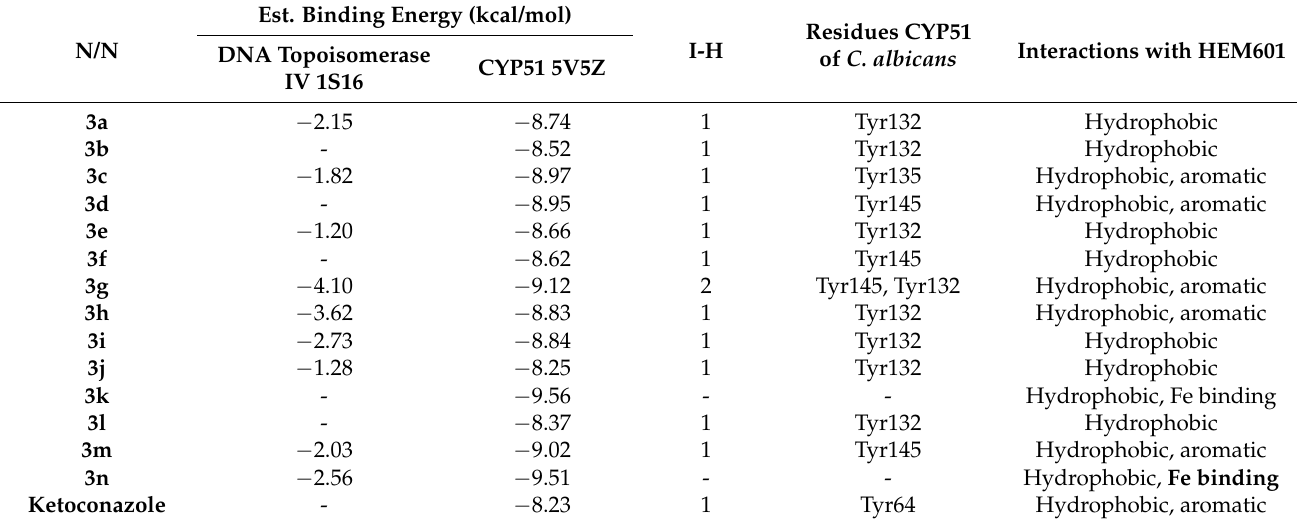
Table 3. Molecular docking on antifungal targets.